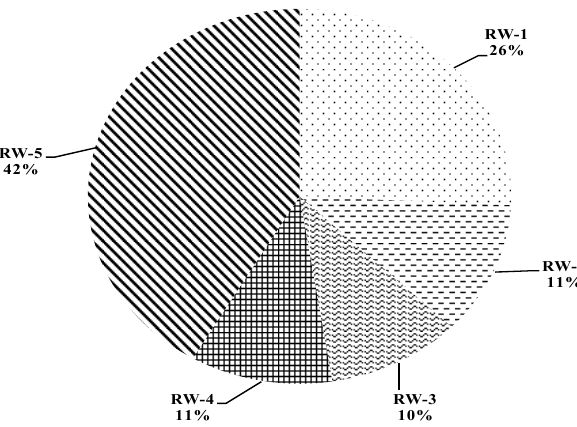
Figure 5. Relative abundance of OCP in di ff erent Ranney well Figure 6. Comparison of Ranney well water quality with respect to various limits samples